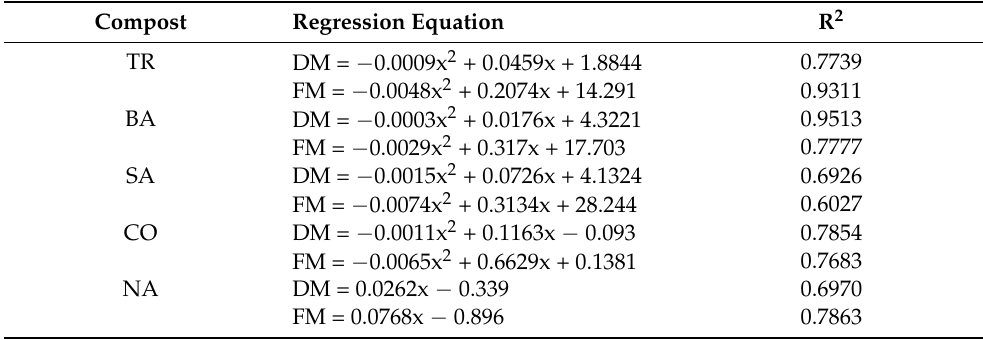
Table 4. Nonlinear and linear regression equations for the relationship between the amount of charcoal (0%, 15%, 30%, 45%, and 60%, weight basis) added to the growth media (composts) and parsley DM and FM yields. The composts were made from poultry industry wastes and tree trimmings (TR), sugarcane bagasse (BA), sawdust (SA), cotton residues (CO), and Napier grass (NA). Compost Regression